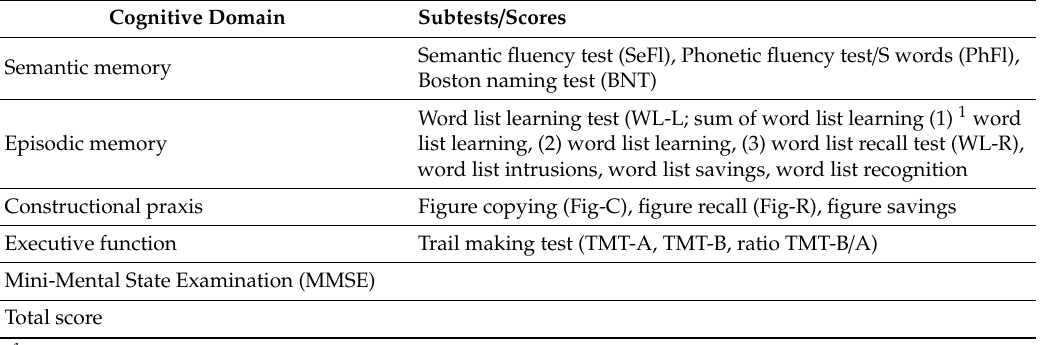
Table 1. The composition of the Consortium to Establish a Registry on Alzheimer’s Disease (CERAD)-Plus